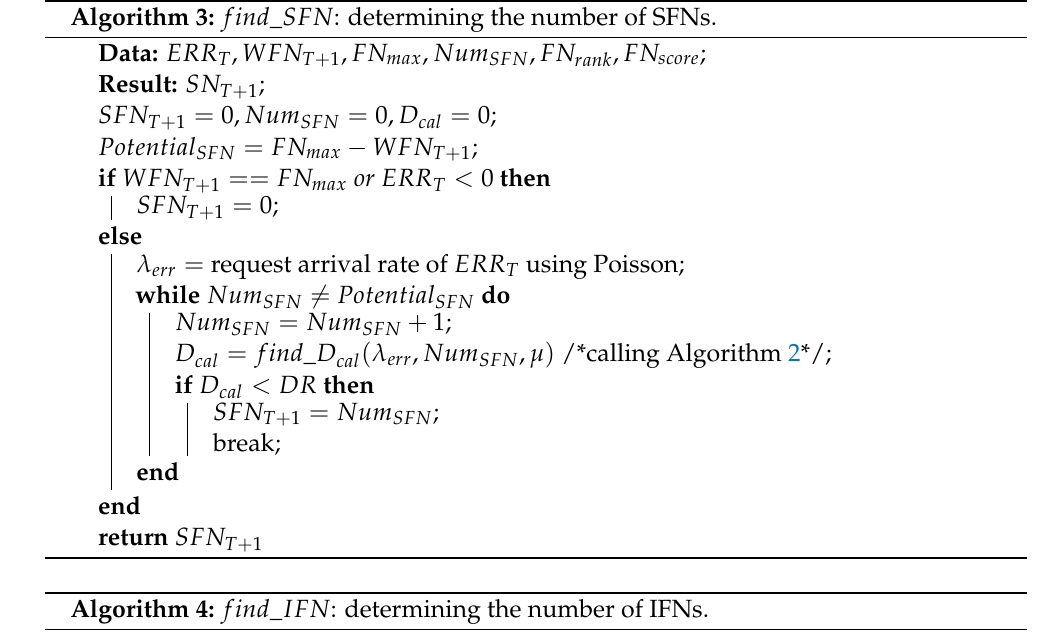
Algorithm 3: f ind _ SFN : determining the number of SFNs.